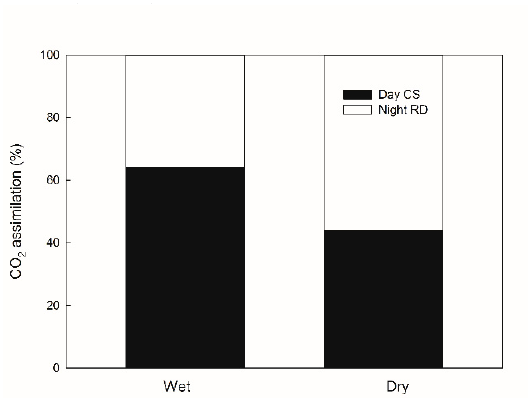
2 assimilation (Am) of Zelkova